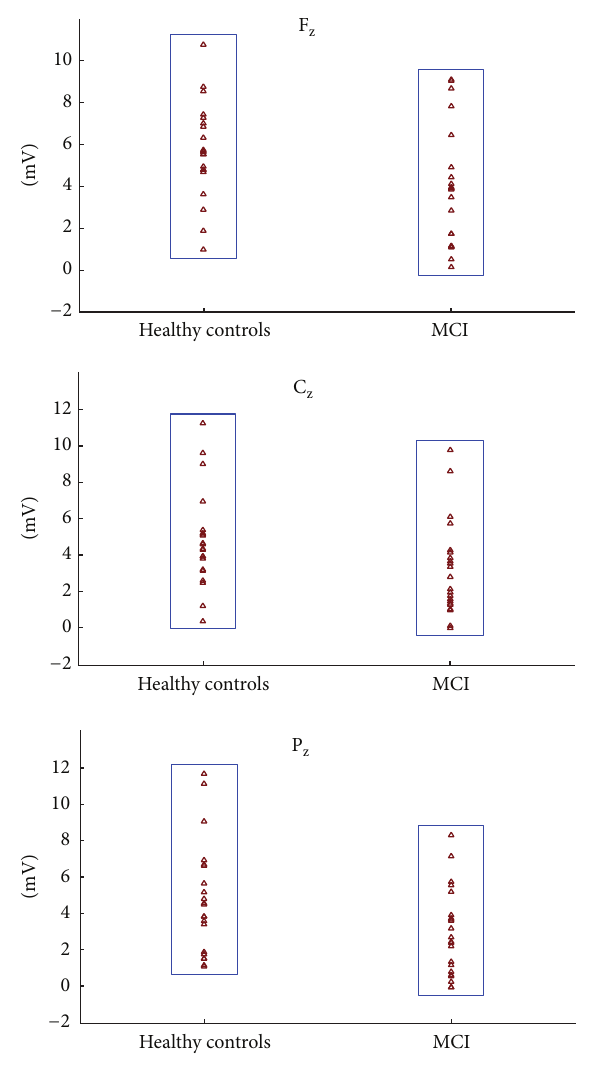
Figure 3: Scattergram of individual delta oscillatory responses of MCI and healthy control subjects on F z , C z , and P z electrode sites.